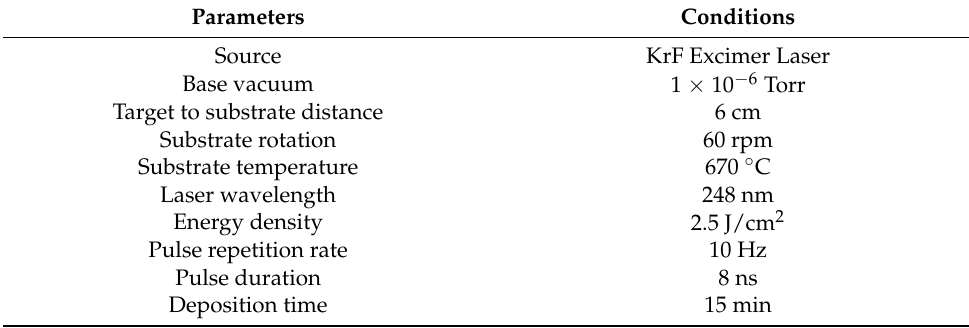
Table 1. PLD experimental conditions for Cr doped In 2 O 3 thin